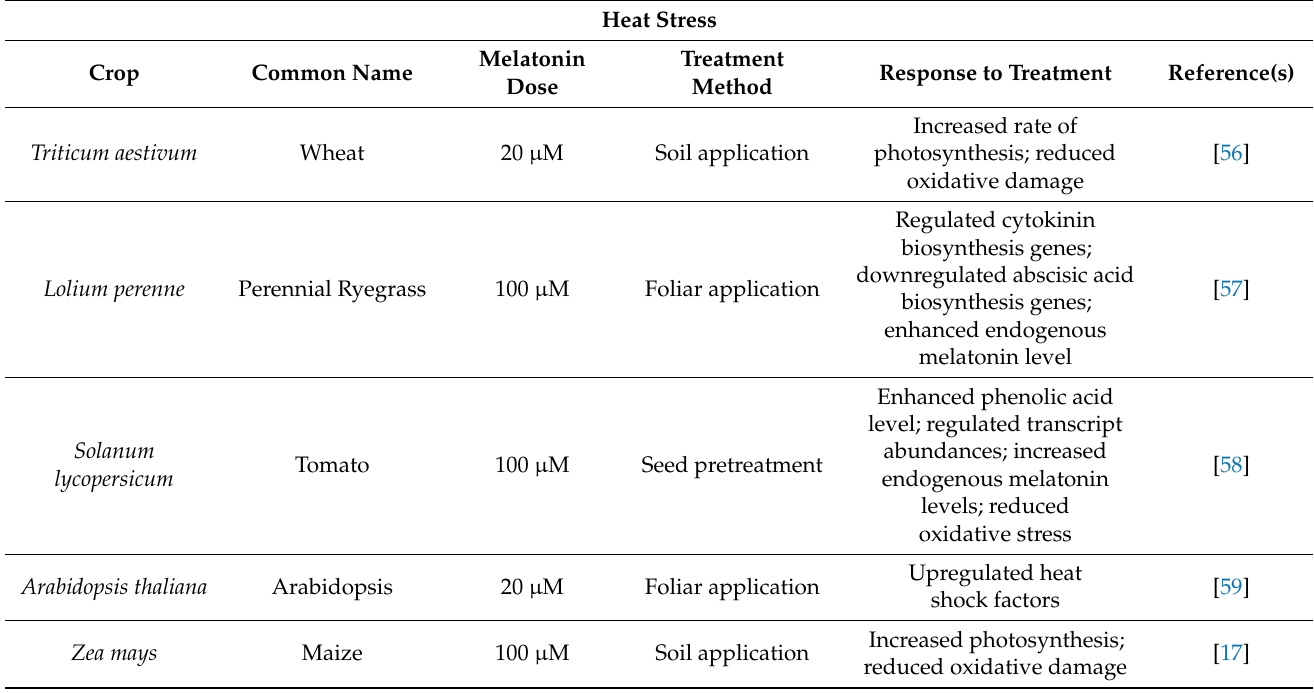
Table 3. Physiological responses of various crops to melatonin treatment against heat